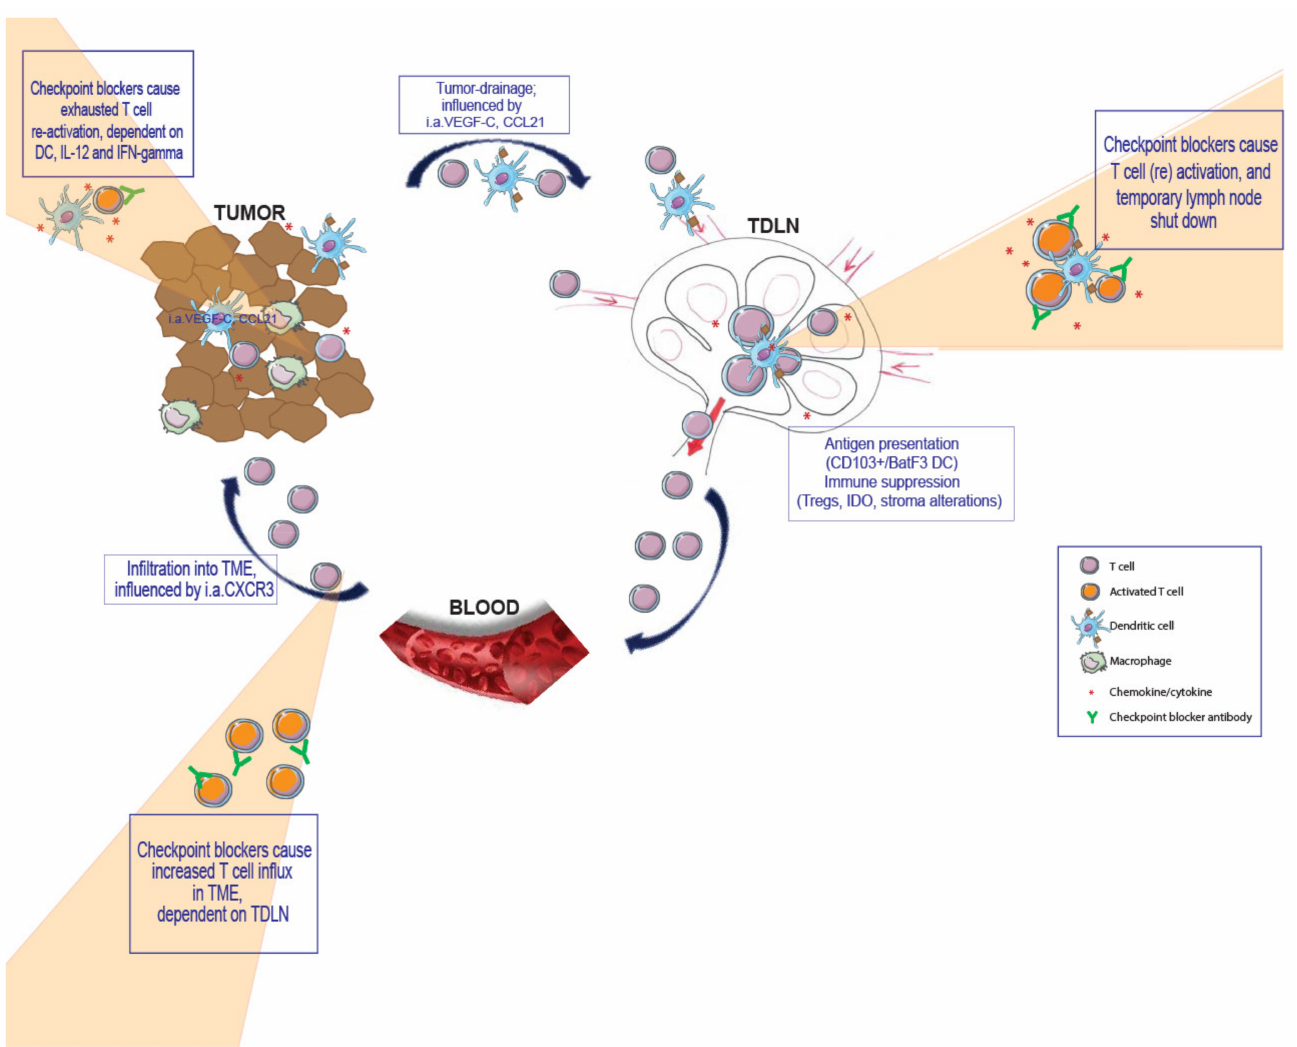
Figure 1. Schematic representation of the proposed working mechanism of checkpoint blocker antibodies for the therapy of cancer. Illustration made using images from Servier (https://smart.servier.com/) 14 May